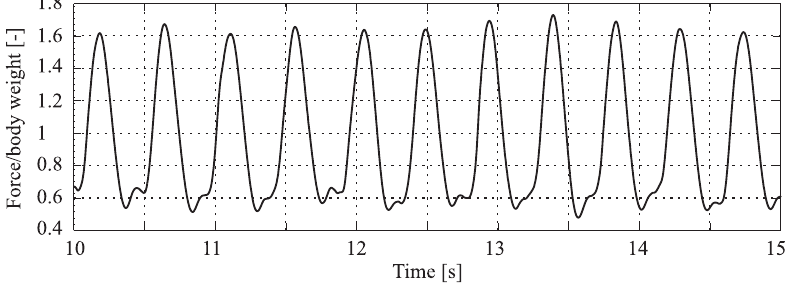
Fig. 3. Vertical force-time history due to a single person